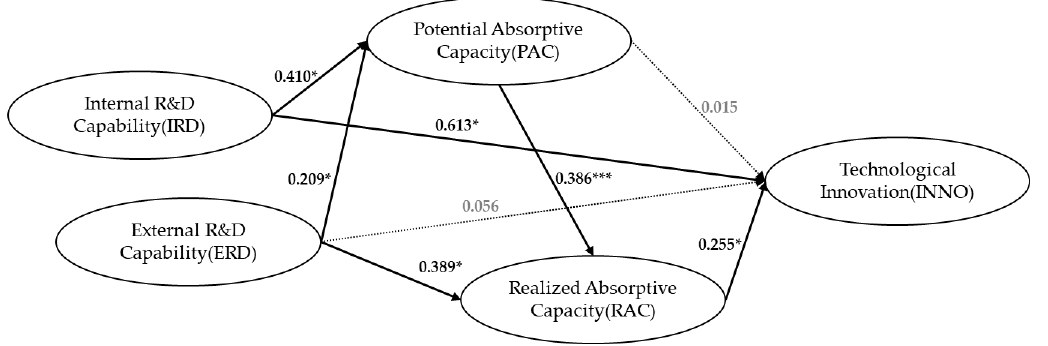
Figure 4. Structural Model. * p < 0.05, ** p < 0.01, *** p < 0.001.